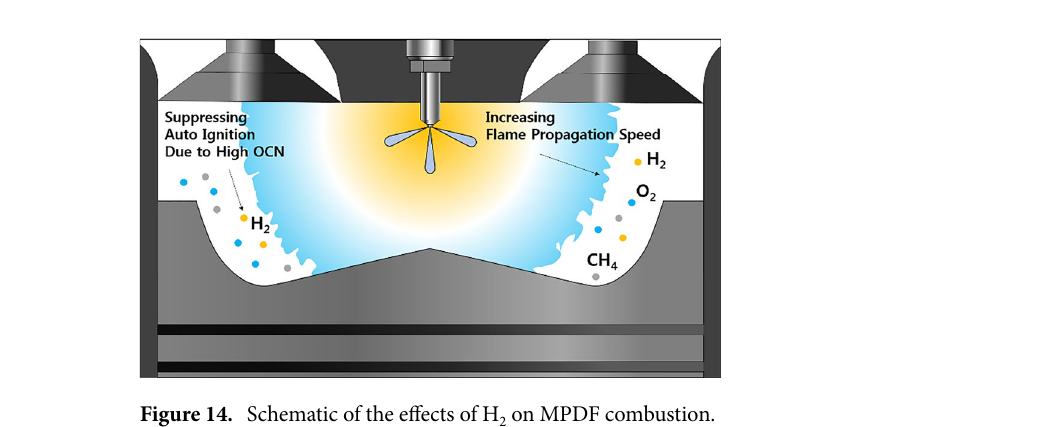
Figure 13. Variation in the cylinder pressure and normalized rate of heat release with the H 2 mixture ratio.